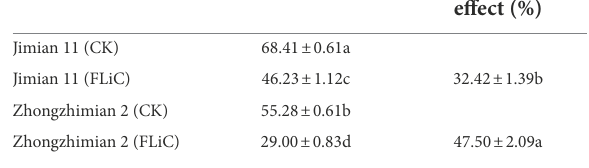
TABLE 1 FLiC induces VD disease resistance in 30-day seedlings of different upland cotton